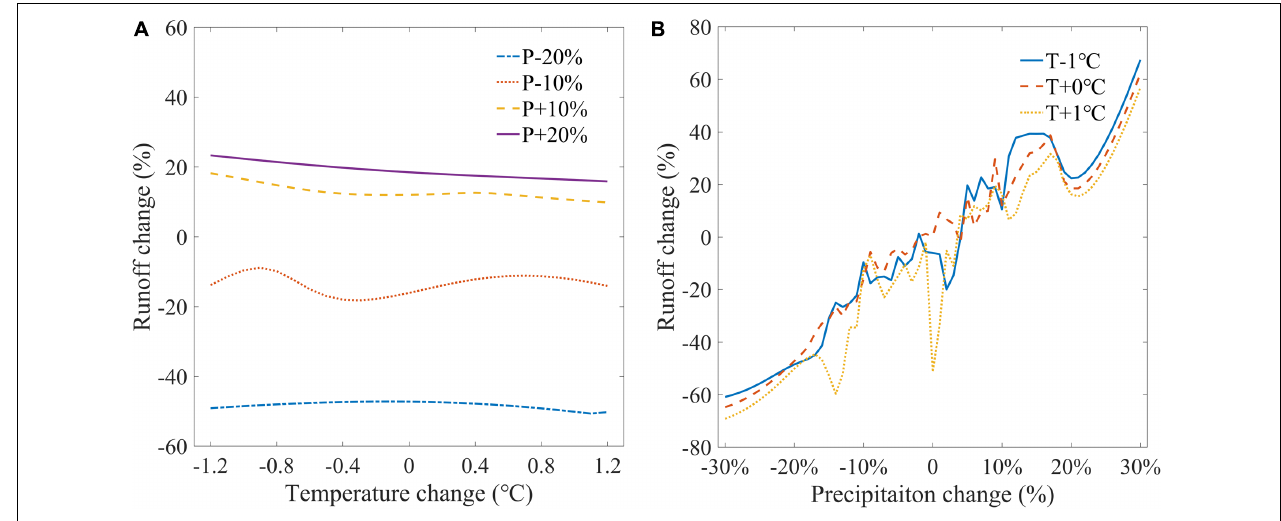
FIGURE 7 | Streamflow changes as function of precipitation changes (A) and temperature changes (B) at different scenarios for the Xi River